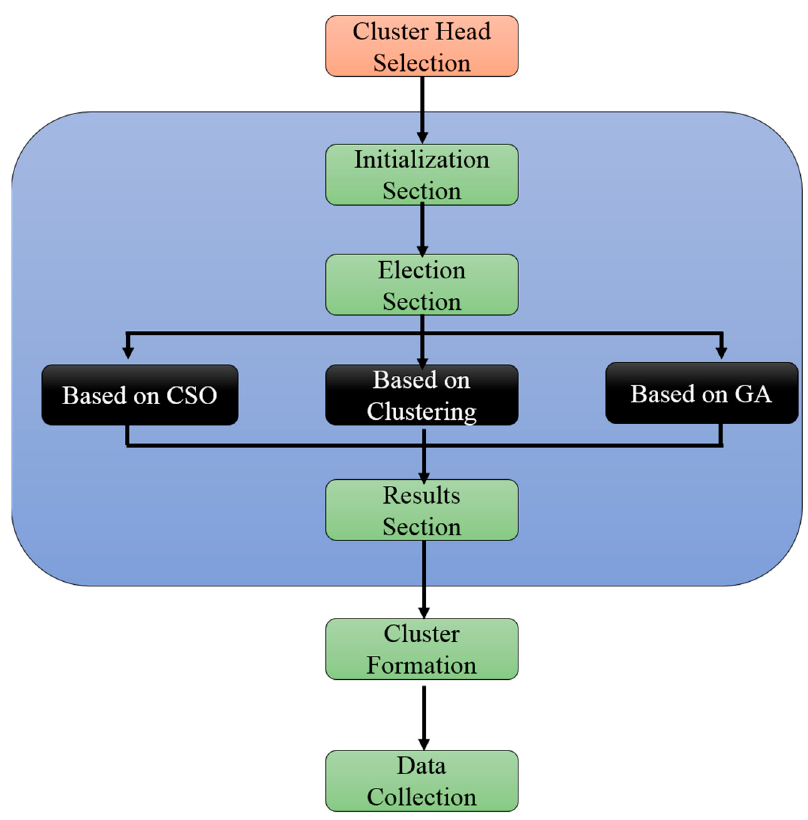
Figure 9. CSO with Genetic Algorithm (CSOGA) architecture.